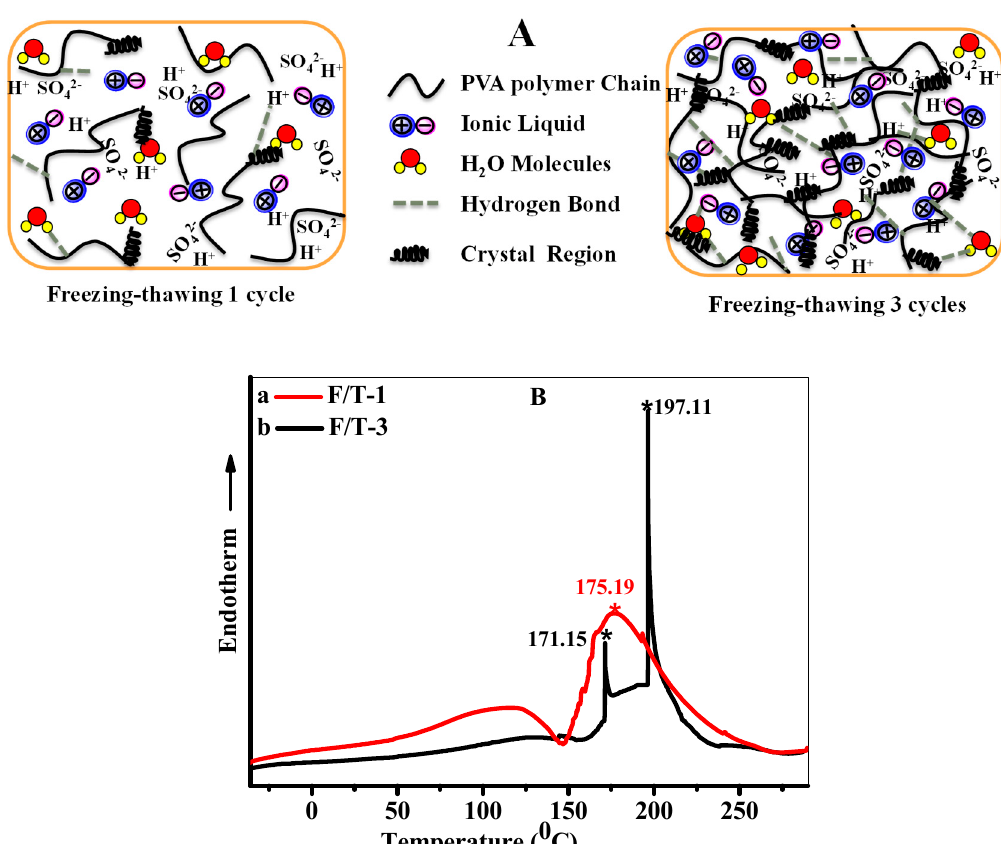
Figure 7. The structure illustration ( A ) and DSC thermogram ( B ) of IL / PVA / H 2 SO 4 GPE subjected to different freezing–thawing cycles.